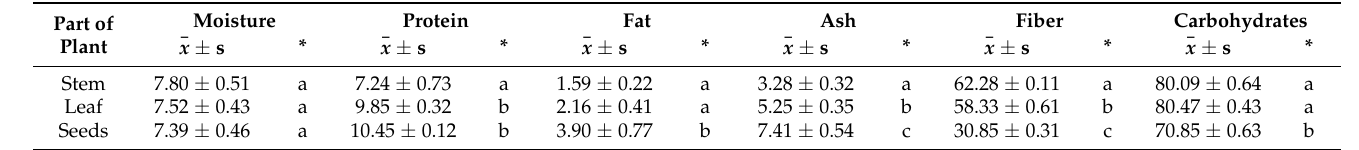
Table 1. Proximal analysis of R. acetosella